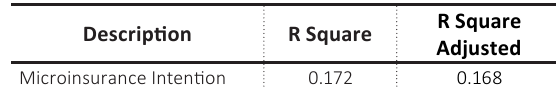
Figure 2. Results of the path Table 6. R Square